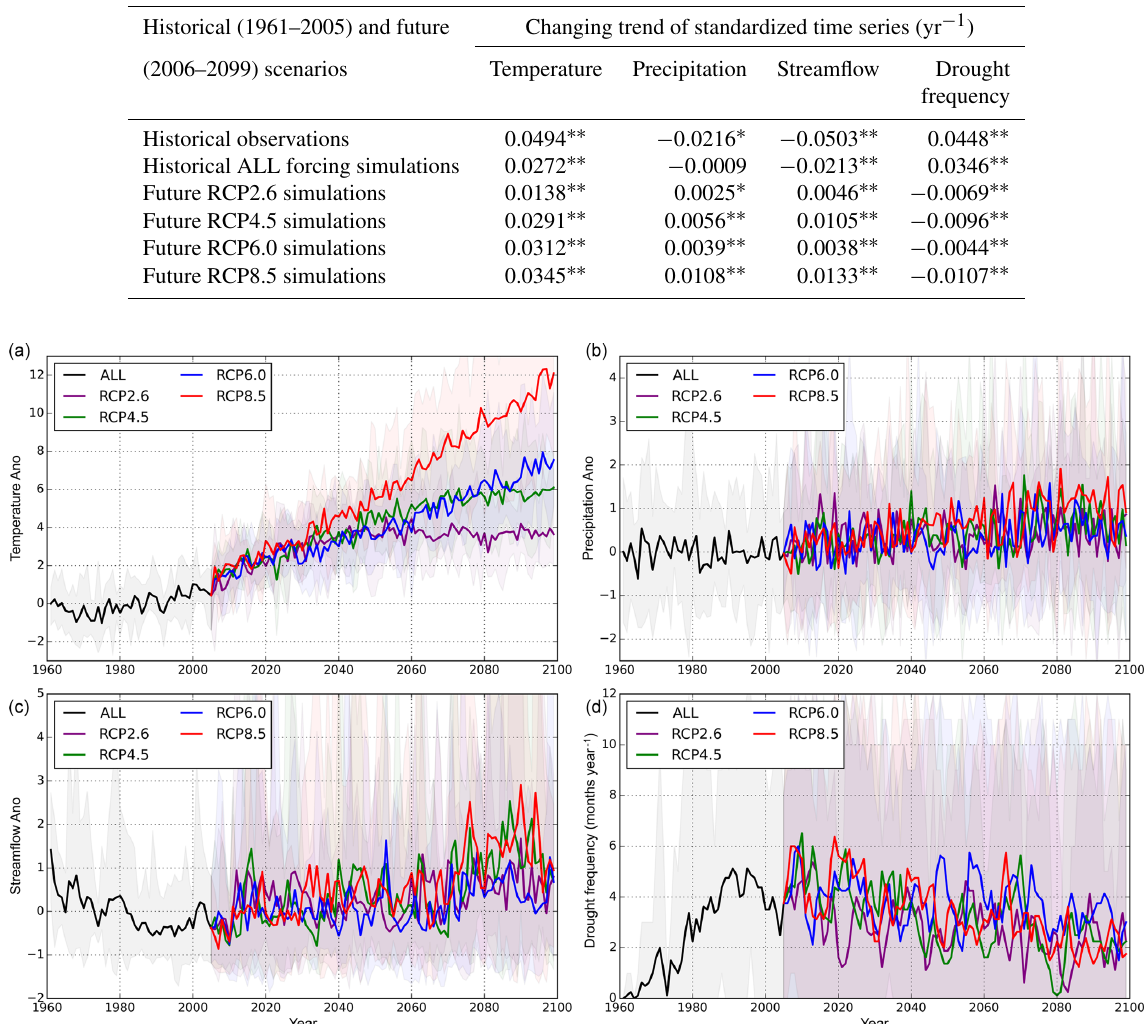
Table 2. Trends in hydrometeorological variables and hydrological drought frequency over the Wudinghe watershed. Historical observed trends for streamflow and drought frequency were calculated by using naturalized streamflow data (Yuan et al., 2017). Here, “*” and “**” indicate 90% and 99% confidence levels, respectively, while those without any “ ∗ ” show no significant changes ( p > 0 . 1).